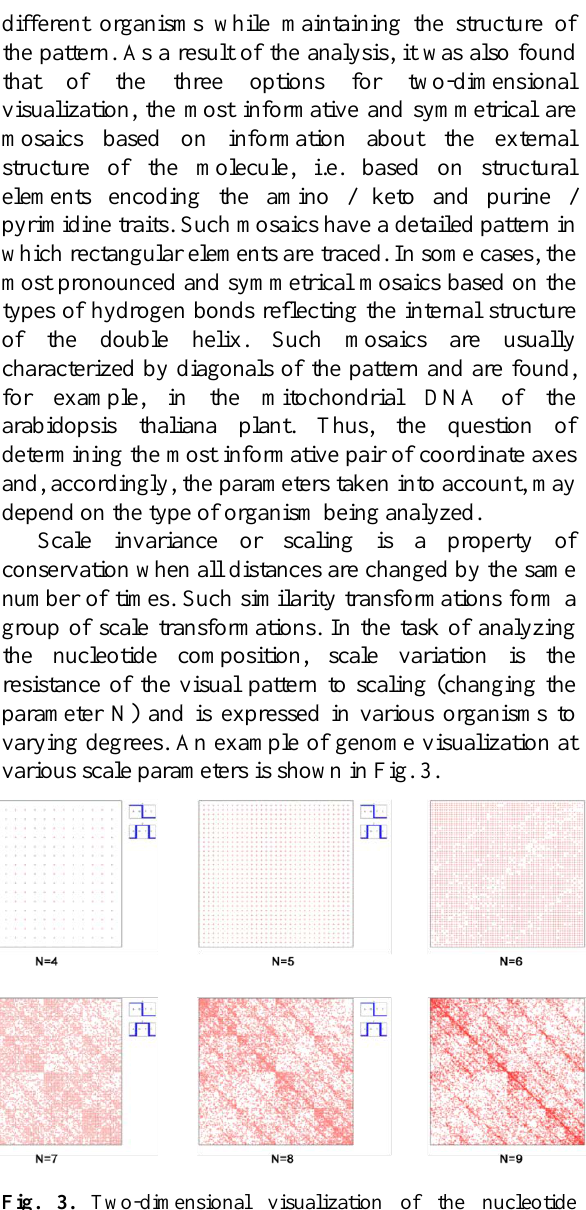
Fig. 3. Two-dimensional visualization of the nucleotide composition of the genome of the chloroplast Fistulifera sp. JPCC DA0580 with various scaling options from 4 to 9.